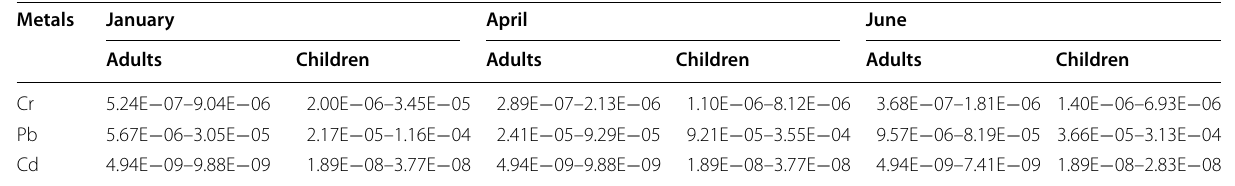
Table 7 Carcinogenic risk assessment (CR ) of Cr, Pb and Cd at different times of groundwater samples collected ing around Muledane village through ingestion pathway for adults and children between January, April and